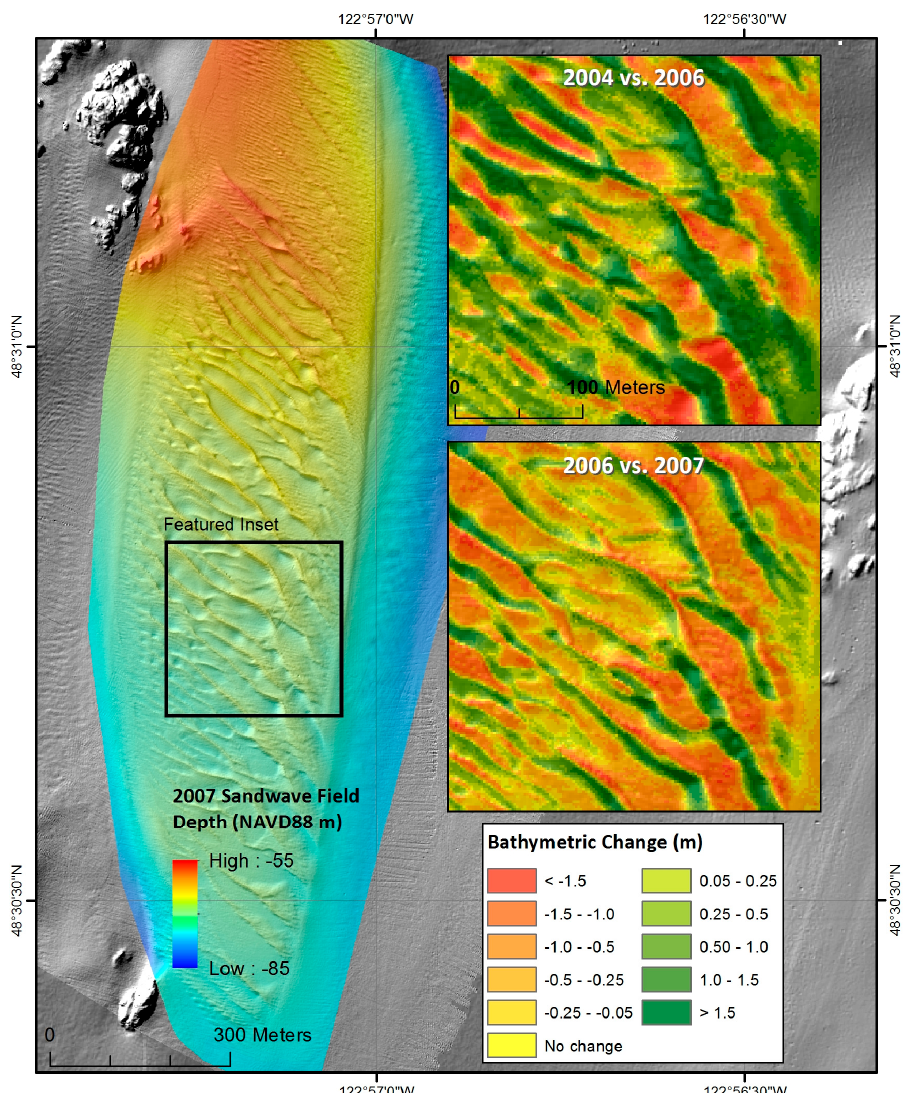
Figure 11. MBES bathymetric image of San Juan Channel sand wave field collected in 2007 with comparisons of changes between years 2004 and 2006 and between 2006 and 2007. Note how the general wave morphology is consistent from one year to the next but that slight sediment erosion (warm colors) and accumulation (green colors), probably the result of shifting back and forth of the sand waves, have occurred.